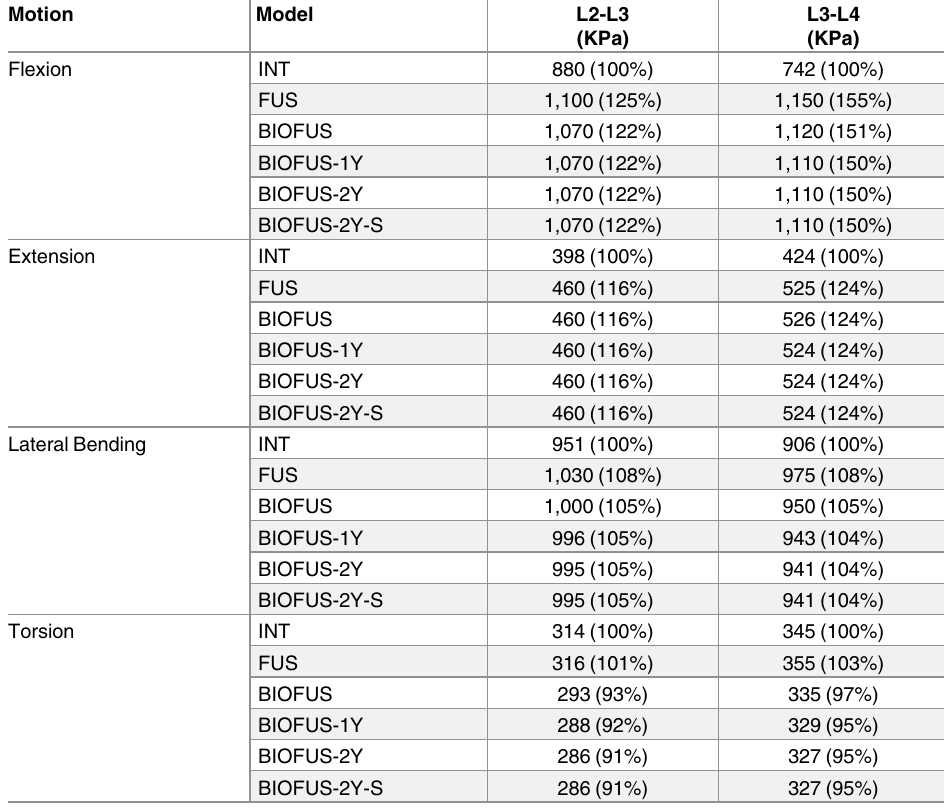
Table 3. Disc stressesat cephalic adjacent